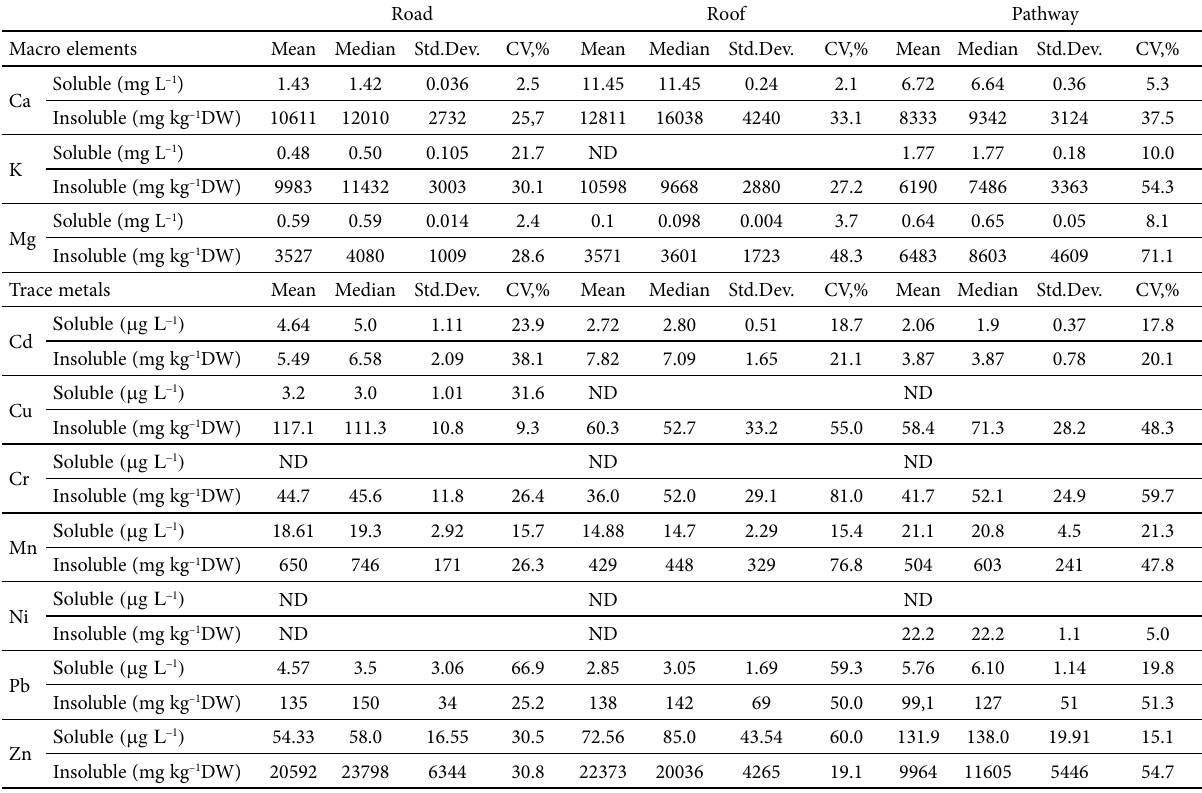
Table 5. Summary of the urban storm water runoff data from the three sampling sites for trace metals and macro elements analysed in soluble and insoluble forms. 9 determinations in all cases. ND not detected as the result was less than the method detection limit Road Roof Pathway Macro elements Mean Median Std.Dev. CV,% Mean Median Std.Dev. CV,% Mean Median